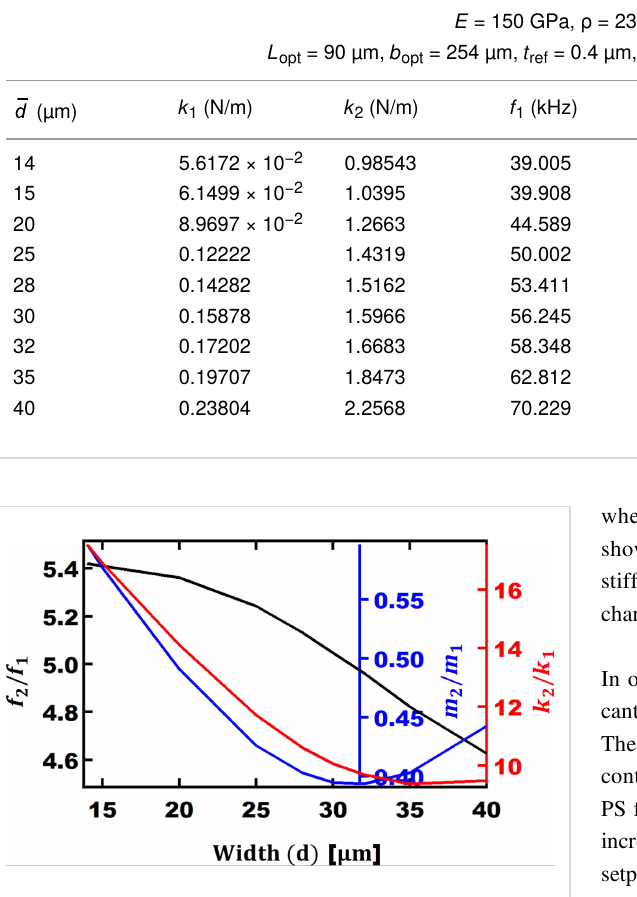
Figure 7: Ratio of second eigenmode to first eigenmode versus each arm’s width ( ) of V-shaped cantilevers for: frequency (black axis), mass (blue axis), and stiffness (red axis). The other geometrical pa- rameters are: L opt = 90 µm, b opt = 254 µm, and t ref = 0.4